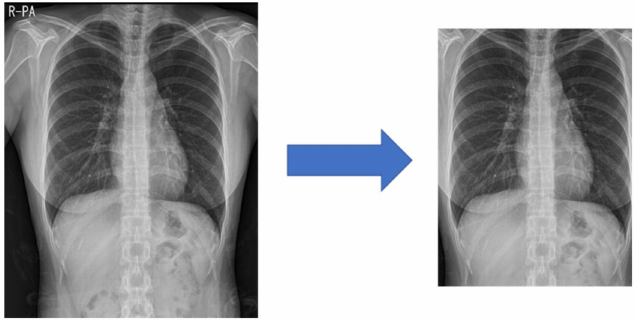
Figure 3. Center cropped image after processing in a 1:1 ratio.